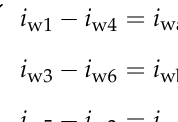
Figure 2. The output current waveform of the current source converter. In a switching cycle, the relationship between the current flow through switches and the converter side current is expressed